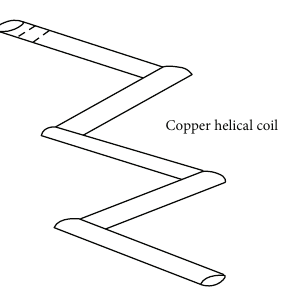
Figure 1: Copper helical